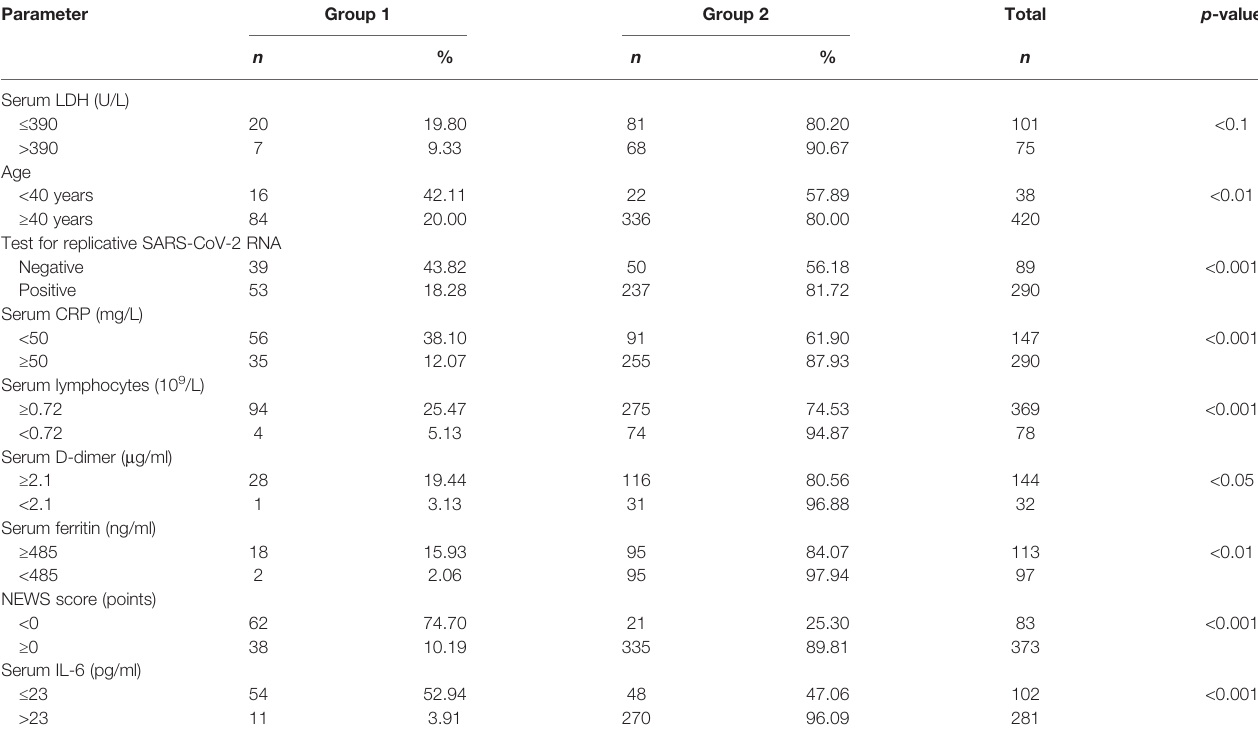
TABLE 5 | Cutoffs for predictive risk factors of CS in groups 1 and 2 at the onset of proactive anti-in fl ammatory treatment. Parameter